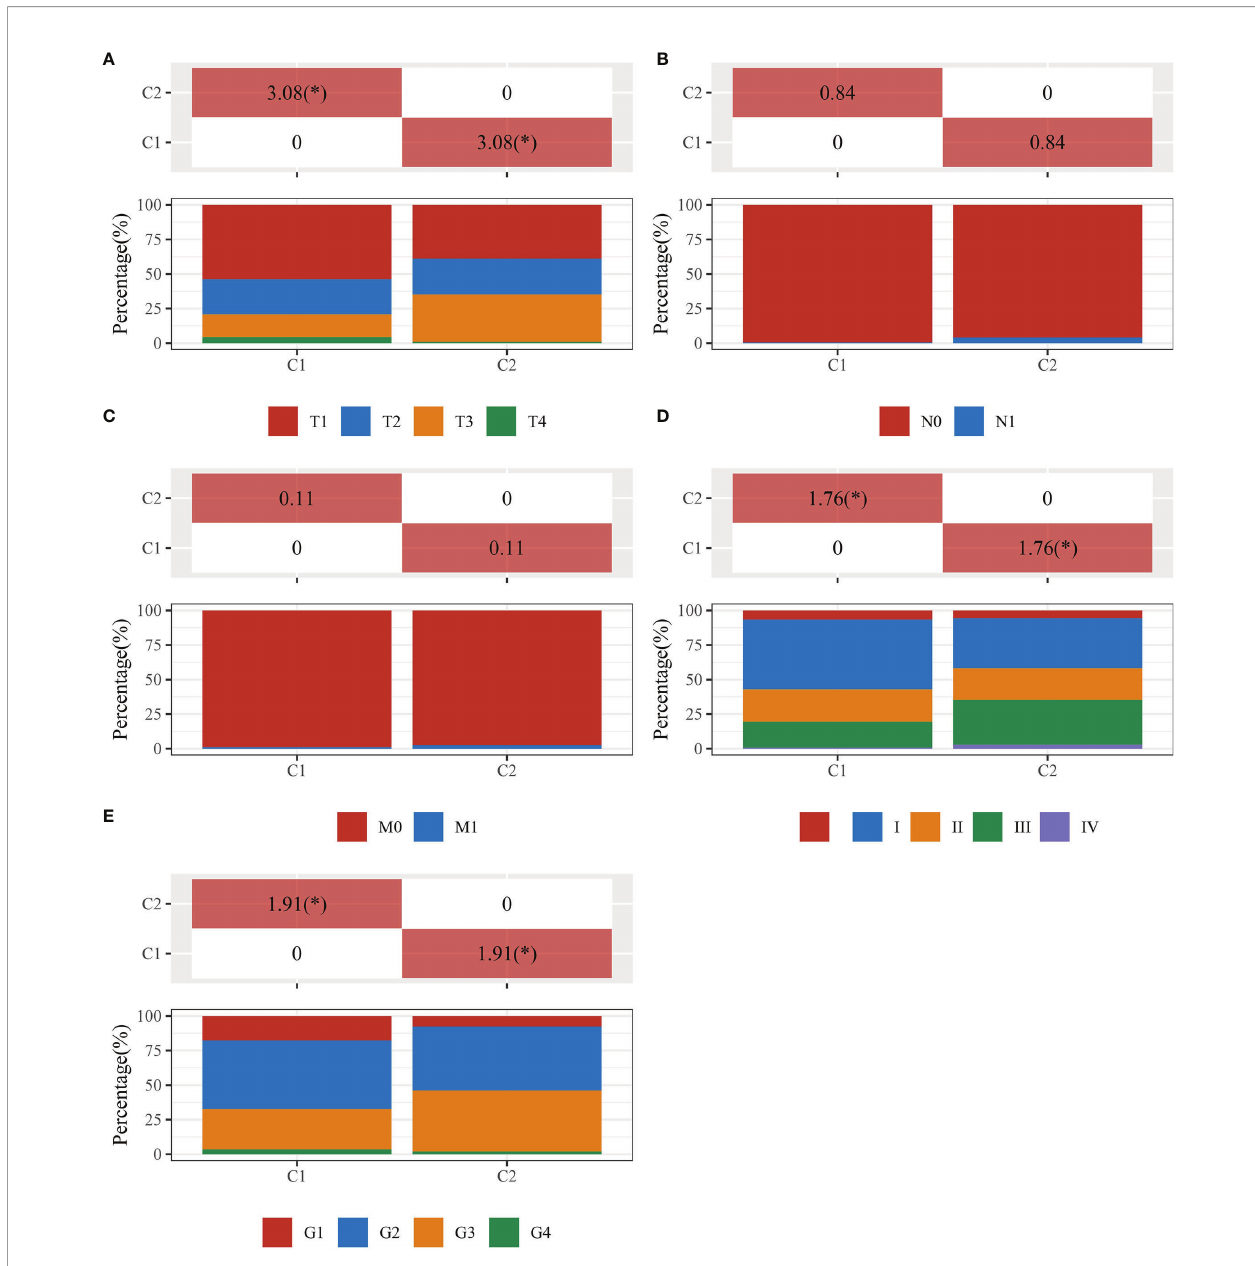
FIGURE 2 | Comparisons of clinical characteristics between C1 and C2. The distribution of clinical characteristics of group C1 and C2. The horizontal axis represents different groups of samples. The vertical axis represents the percentage of clinical information contained in the corresponding grouped samples. The table above shows the p -value (-log10) of clinical feature signi fi cance in the two groups, which calculated by the chi-square test. The * mark indicates a signi fi cant difference in clinical features between the two groups ( P <0.05). (A) T category. (B) N category. (C) M category. (D) TNM staging. (E) Pathological